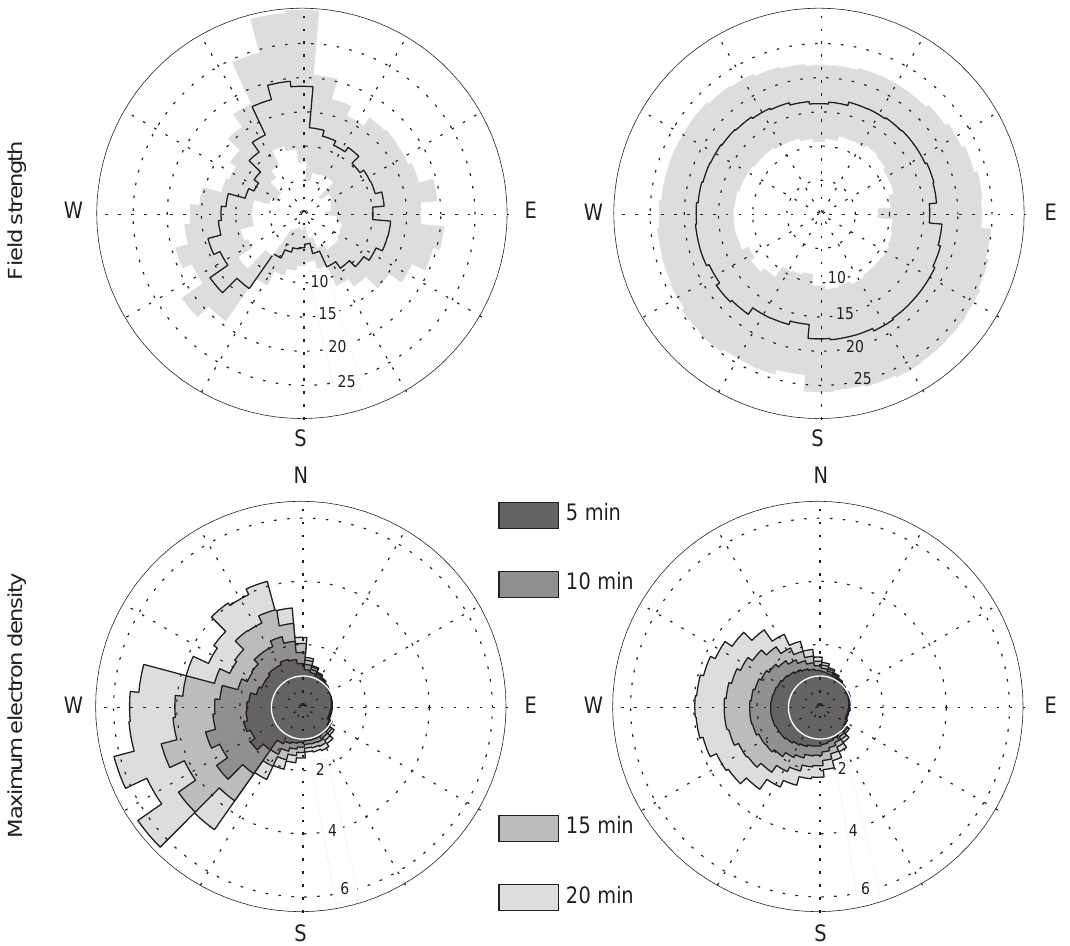
Fig. 6. Top panels: The average value of electric field intensity at Longyearbyen (left) and Thule (right) as a function of electric field direction. The electric field is calculated by means of the APL model using all directions of the IMF projection on the B y B z plane and values 4, 6 and 8nT. The shaded area indicates the standard deviation of the electric field intensity. The electric field direction is shown with respect to local geomagnetic north. Bottom panels: The peak values of calculated sporadic-E electron density, due to the average electric field, are shown in the top panels after 5-, 10-, 15- and 20-min compression. The start profile of the ion density is the same as in Fig. 1, and it is plotted by a white